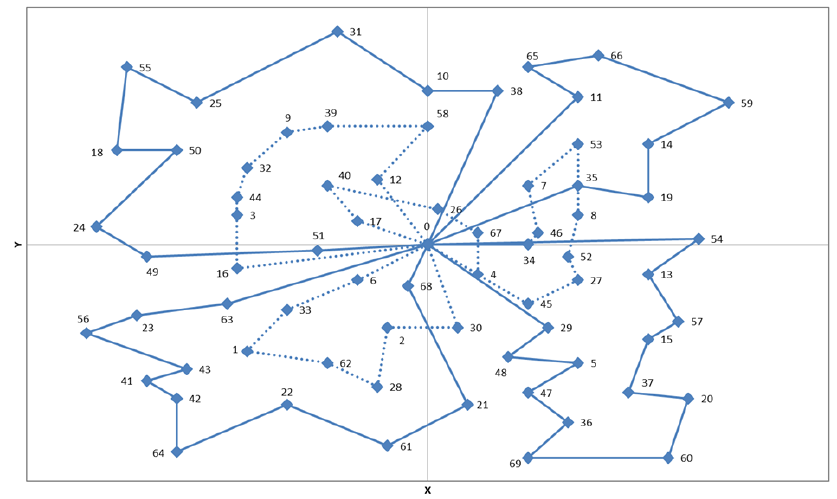
Fig. 7. Routes obtained considering dynamic